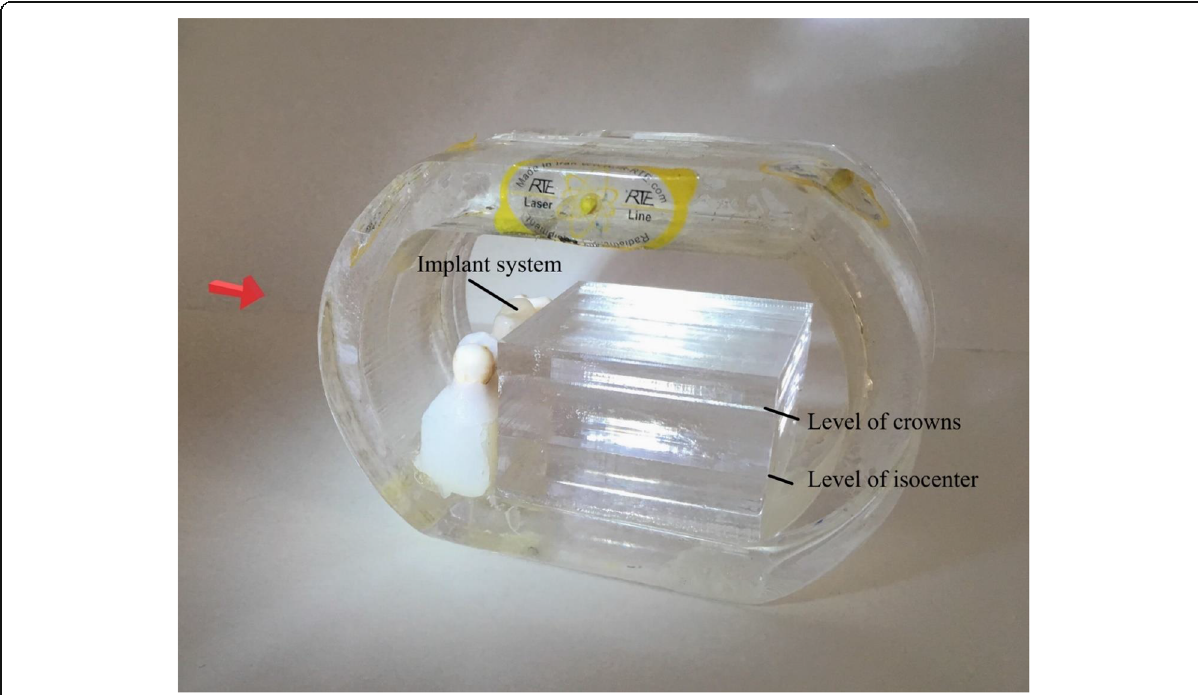
Fig. 1 Oral cavity phantom made of Perspex, Teflon, and teeth. The placement of EBT-3 films at two levels is shown. The red arrow shows the direction of the radiotherapy